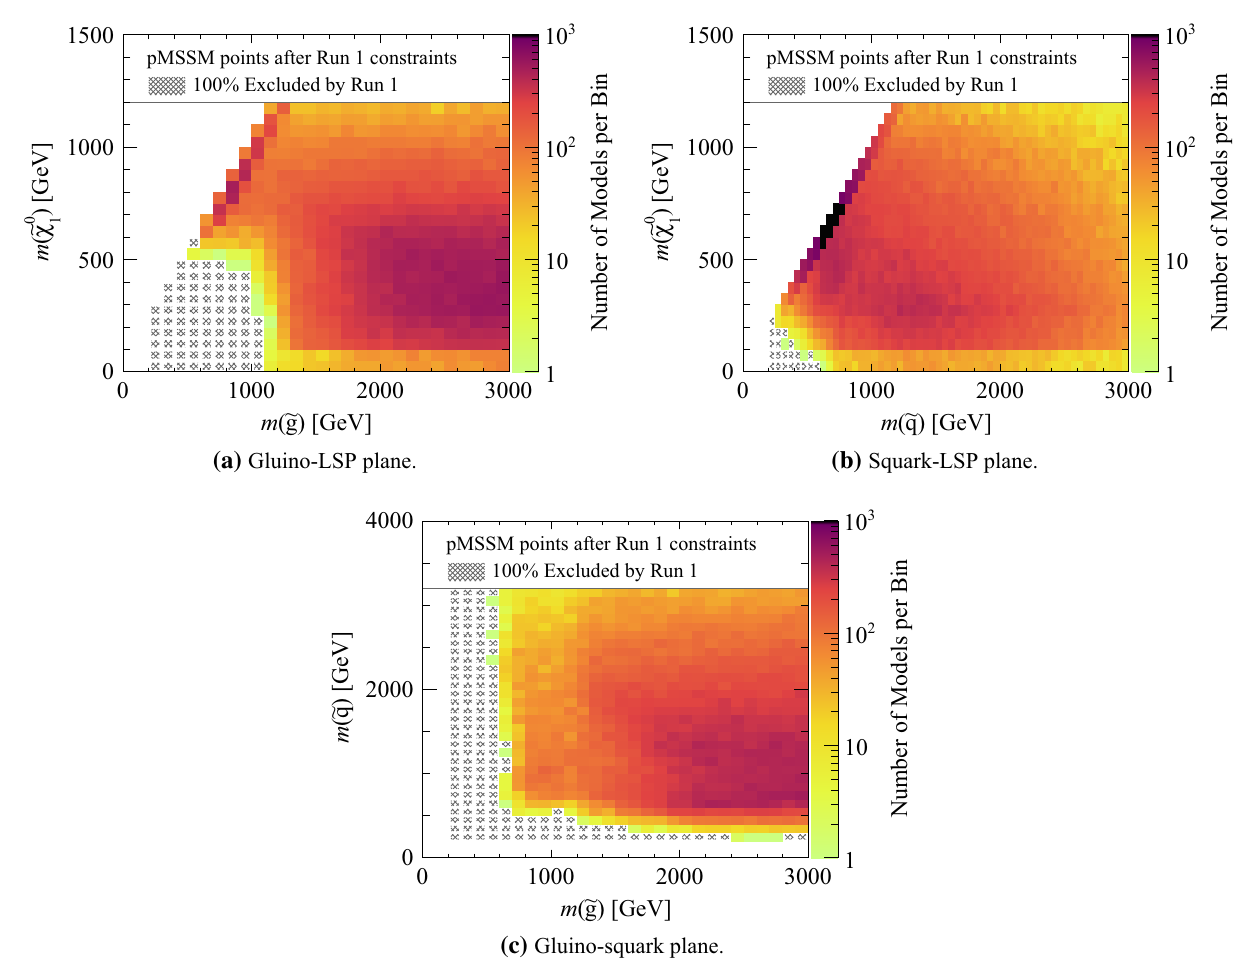
(b) Squark-LSP plane.